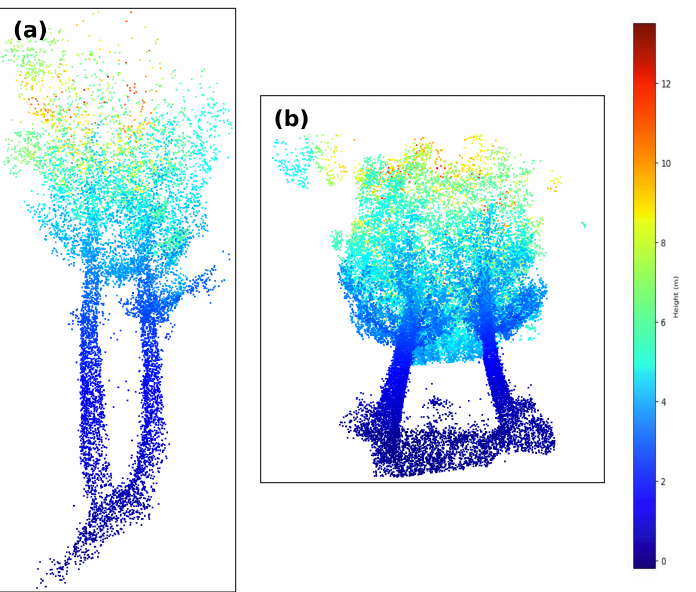
Figure 18. Examples of hard human classification trees. ( a ) Close trunks that can be interpreted as one tree or two. ( b ) Two trees with nearby